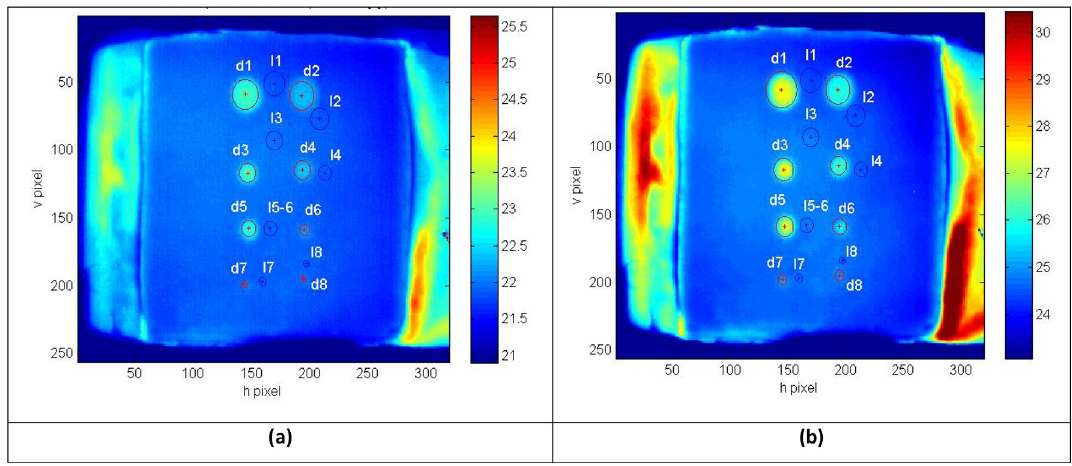
Fig. 11 Thermal processing defect with traditional thermography and different heating time: a 3 s; b 10